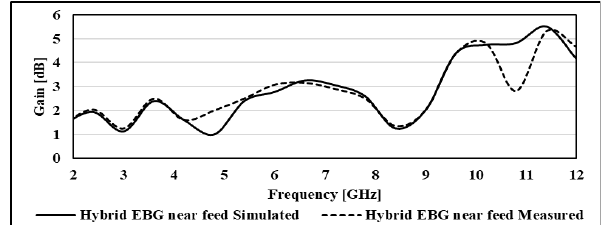
Figure 20. Variation in S-parameter vs frequency for UWB-CMSA with hybrid